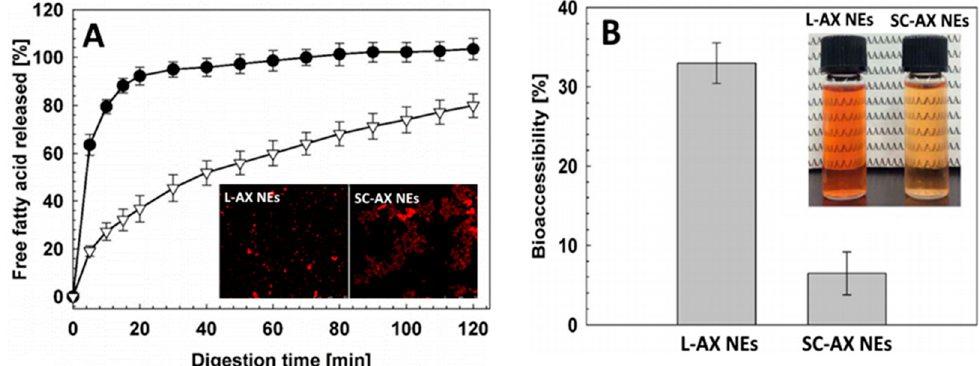
Figure 4. In vitro fatty acid release after digestion of lecithin and sodium caseinate-stabilized astaxanthin NEs in small intestine digestion model. In vitro fatty acid release after digestion of lecithin and sodium caseinate-stabilized astaxanthin nanoemulsions in small intestine digestion model along with an inset showing their respective confocal microscopic images ( A ) and their bioaccessiblity along with the photographs showing the appearance of NEs ( B ). The results were expressed as mean ± standard deviation of ≥ 3 independent replicates and error bars represent the standard deviation from the mean values. L-AX NEs = lecithin-stabilized astaxanthin nanoemulsions and SC-AX NEs = sodium caseinate-stabilized astaxanthin nanoemulsions. Adapted with permission from Khalid, et al. [77].